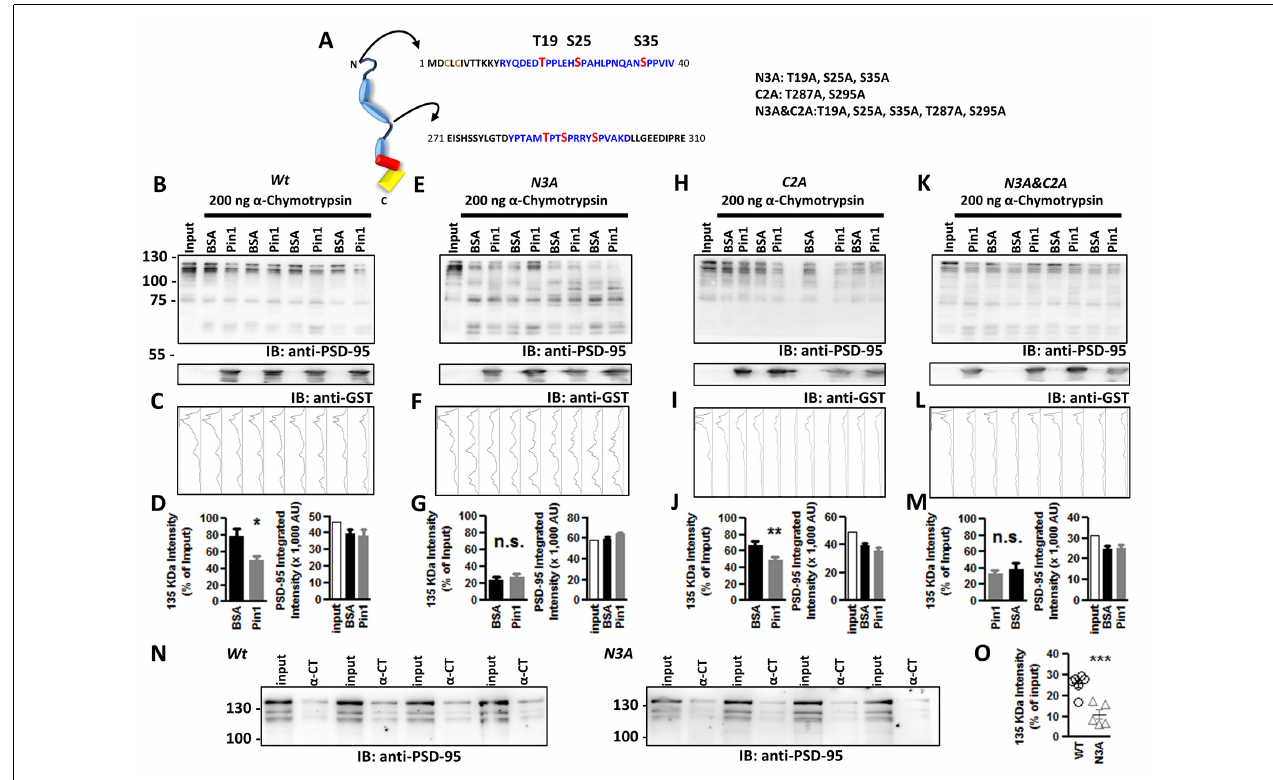
FIGURE 4 | Phospho-T19, S25, and S35 in the N-terminus domain of PSD-95 are sites of Pin1 isomerization. (A) Schematic diagram of PSD-95 indicating putative Pin1 binding sites (shown in blue) and phosphorylated sites in red. Abbreviated mutant is shown on right including the sites mutated on each one. (B) Immunoblot showing the result of the in vitro a-chymotrypsin cis-trans isomerization of wt PSD-95, (E) the N3A, (H) the C2A, and (K) the N3A/C2A mutant. COS cells homogenates expressing wt or mutants of PSD-95::EGFP were incubated with 1 mg BSA or GST-Pin1 and subjected to Western immunoblotting with anti-PSD-95 and anti-GST antibodies. (C, F, I, L) Integrated band intensity for all the bands. Each lane corresponds to the PSD-95 immunostained column above. (D, G, J, M) Quantification of immunoblot intensities normalized to input lane value for the 135 kDa band. (D) Wt, BSA 78.78 ± 8.628% vs. Pin1 49.74 ± 5.722%; n = 9, * p < 0.05 unpaired t-test. (G) N3A, T19A, S25A, S35A PSD-95::EGFP triple mutant BSA 23.78 ± 3.246% vs. Pin1 27.44 ± 3.689%, n = 8; (J) C2A T287A, S295A PSD-95::EGFP double mutant BSA 67.38 ± 13.39% vs. Pin1 49.68 ± 10.10%, n = 8 and (M) the N3A&C2A T19A, S25A, S35, T287A, S295A PSD-95::EGFP Penta mutant BSA 34.47 ± 7.712% vs. Pin1 37.69 ± 3.426%, n = 6. * p < 0.05 and ** p < 0.01 unpaired t -tests. For all, (right bar graph) the difference in rates of PSD-95 degradation by Pin1 is not explained by differences in loaded protein. (N) Isomerization assay performed as before without the addition of GST-Pin1 to lysates. Cells transfected with wild type PSD-95 or the N3A. (O) Quantification of immunoblot band intensities normalized to input lane values for the 135 KDa band 25.72 ± 1.87%, n = 6 for PSD-95::EGFP and 10.99 ± 2.37%, n = 5 for PSD-95::EGFP N3A, *** p < 0.0008. Four independent pairs of reactions shown. All values are reported as mean ± SEM. n.s., not